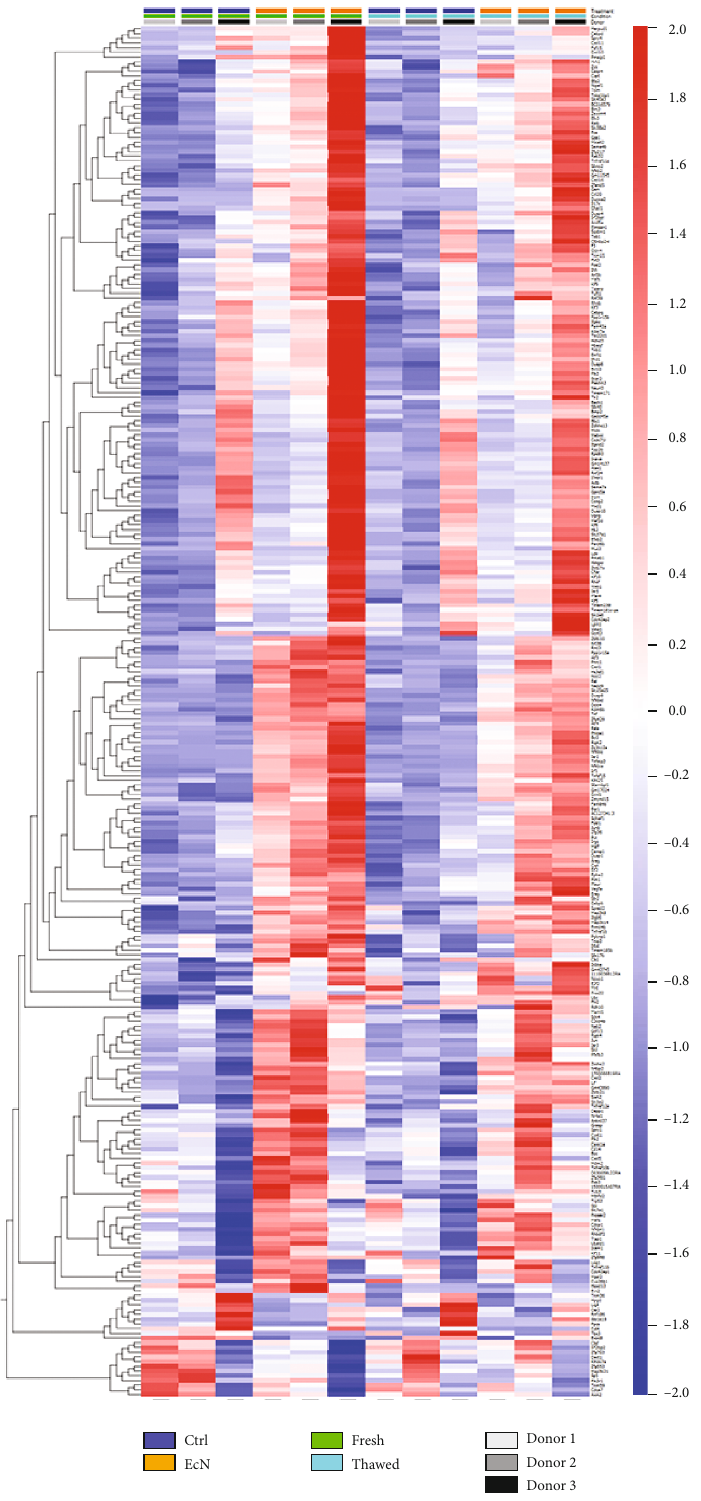
Figure 4: Fresh and cryopreserved organoids exhibit a similar gene expression pro fi le in response to Ec N injection. Heat map displaying signi fi cantly (adjusted P value < 0.01) di ff erentially expressed genes detected between Ec N and control samples in fresh colonoids. Besides the normalized and log transformed expression levels of the samples originating fresh organoids, the heat map includes in an analogous manner the samples of thawed